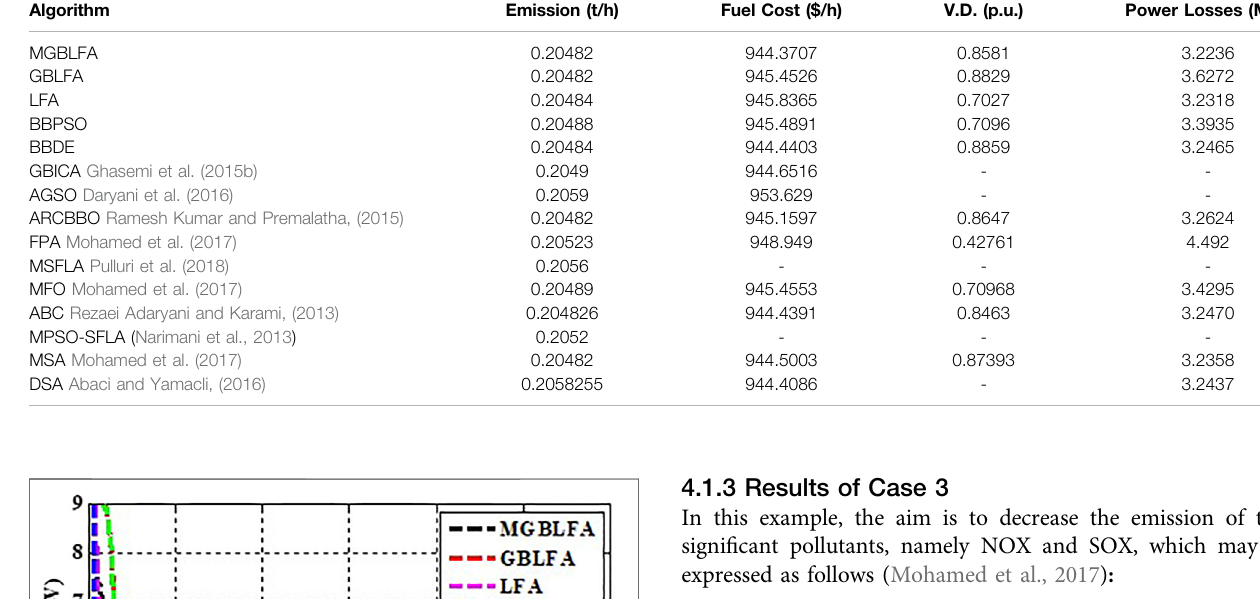
TABLE 4 | Comparison of optimal results by algorithms for case 3. Algorithm